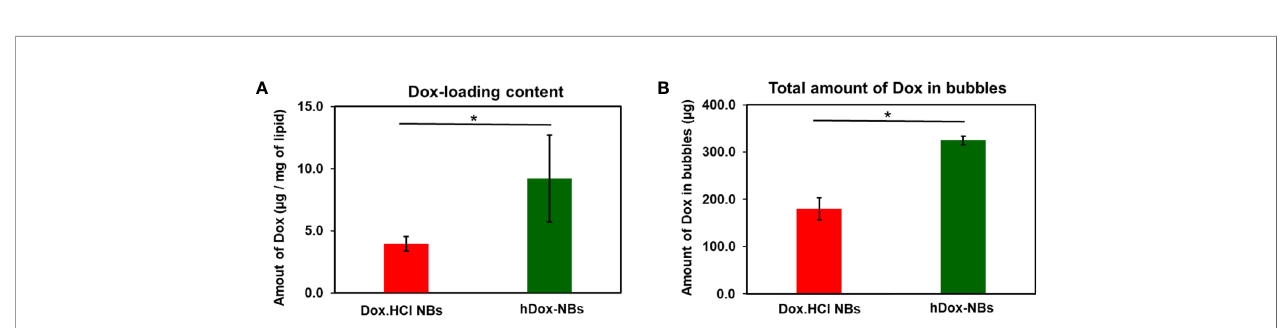
FIGURE 3 | Summary of drug loading into bubbles for hDox (n=3) and Dox.HCl (n=3). (A) hDox loading content per milligram of lipid; (B) Total hDox amount in bubbles ( m g) calculated based on the buoyant particle concentration of both bubble types measured by resonant mass measurement (RMM). Dox in non-buoyant particle fraction was removed from this analysis. Signi fi cantly increased drug-loading of hDox can be seen in both test. Error bars represent standard deviation. Asterisk indicates signi fi cant difference at signi fi cant difference at p < 0.05.